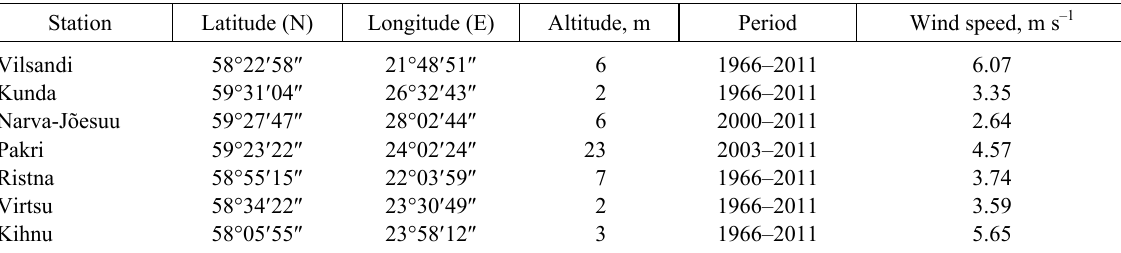
Table 2. Information on meteorological stations used or discussed in the study. Wind speed in 2011 is based on hourly one- hour sustained